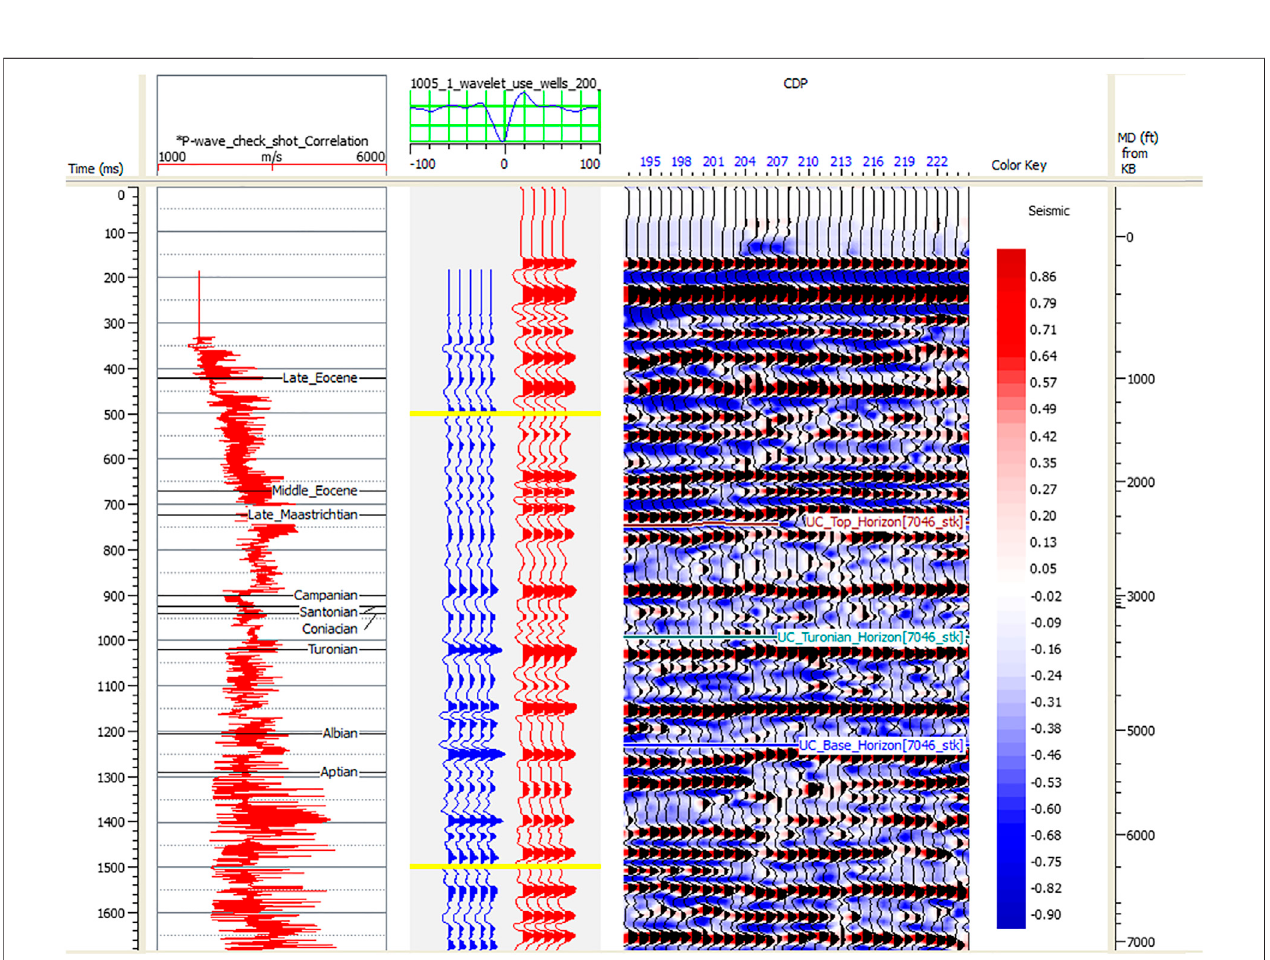
FIGURE 5 | Seismic well correlation, achieved by matching events on the synthetic with the same events on seismic trace at the Transco 1005-1 well.